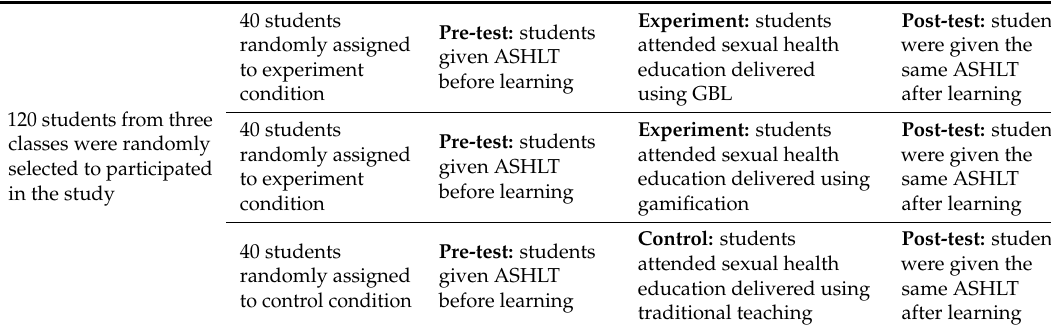
Table 1. Randomized control trial for this